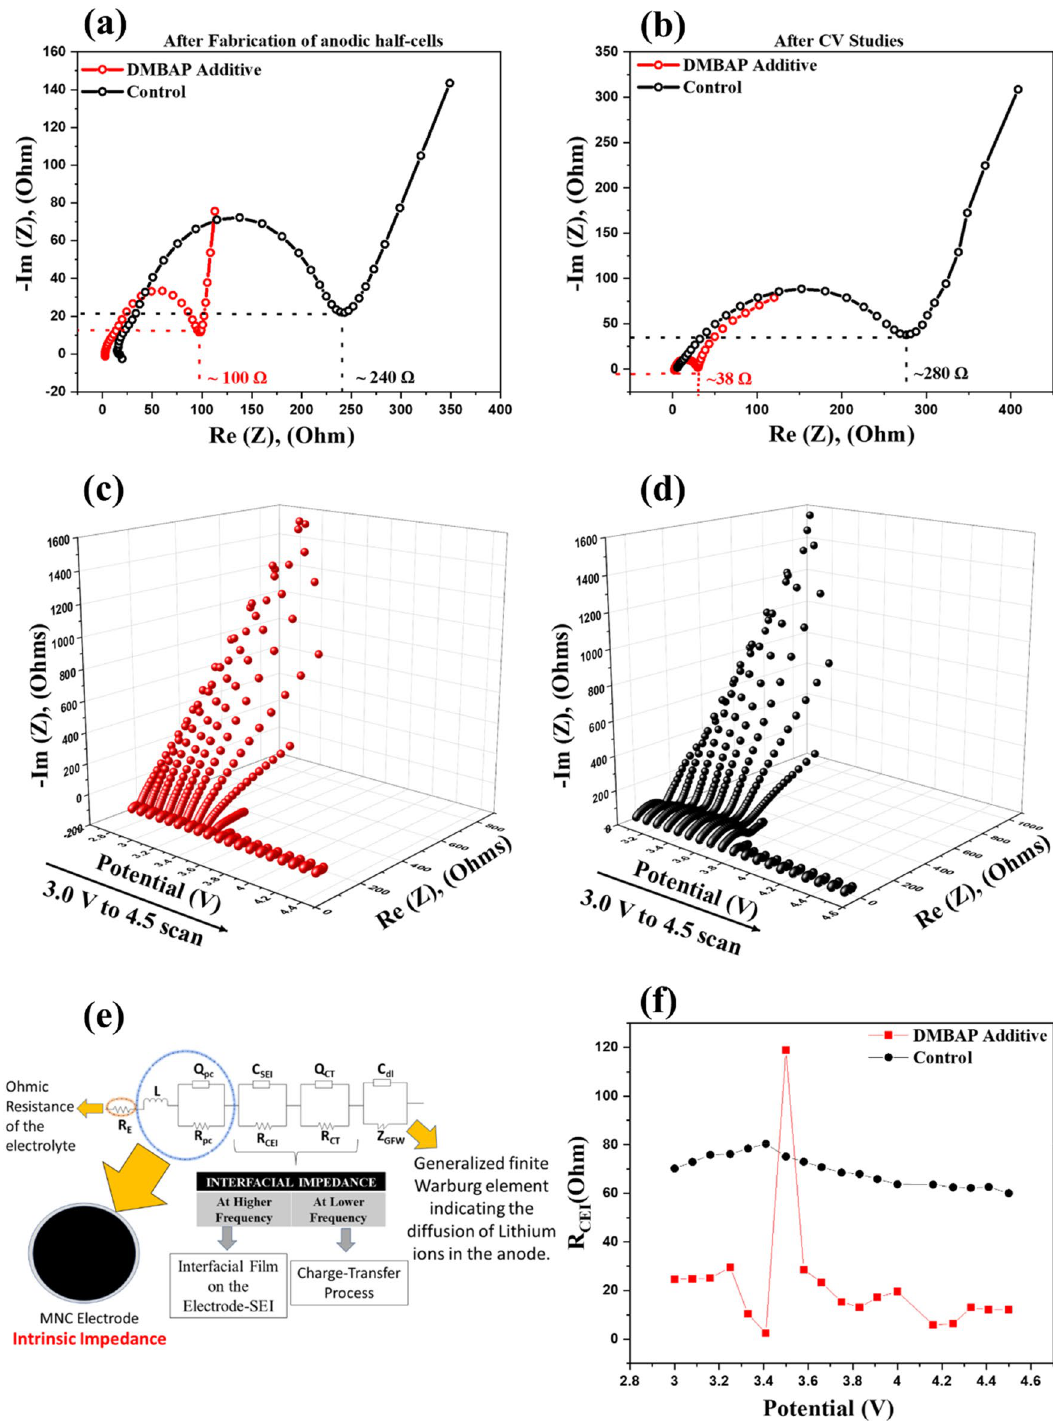
Figure 4. Impedance Spectroscopy Studies. Nyquist impedance profile comparison for DMBAP-based cathodic half-cell and control system ( a ) after fabrication and ( b ) after CV studies, respectively. DEIS 3-D Nyquist profiles after delithiation half-cycle of ( c ) DMBAP-based cathodic half-cell and ( d ) control system-based cathodic half- cell. ( e ) The best fit Equivalent Electrical Circuit Model (EECM) for computational simulation of 3D-Nyquist Impedance profiles for both systems, and ( f ) CEI impedance (R CEI ) versus potential (V) comparison profiles during lithiation half-cycle in case of DMBAP-based cathodic half-cell and control system,